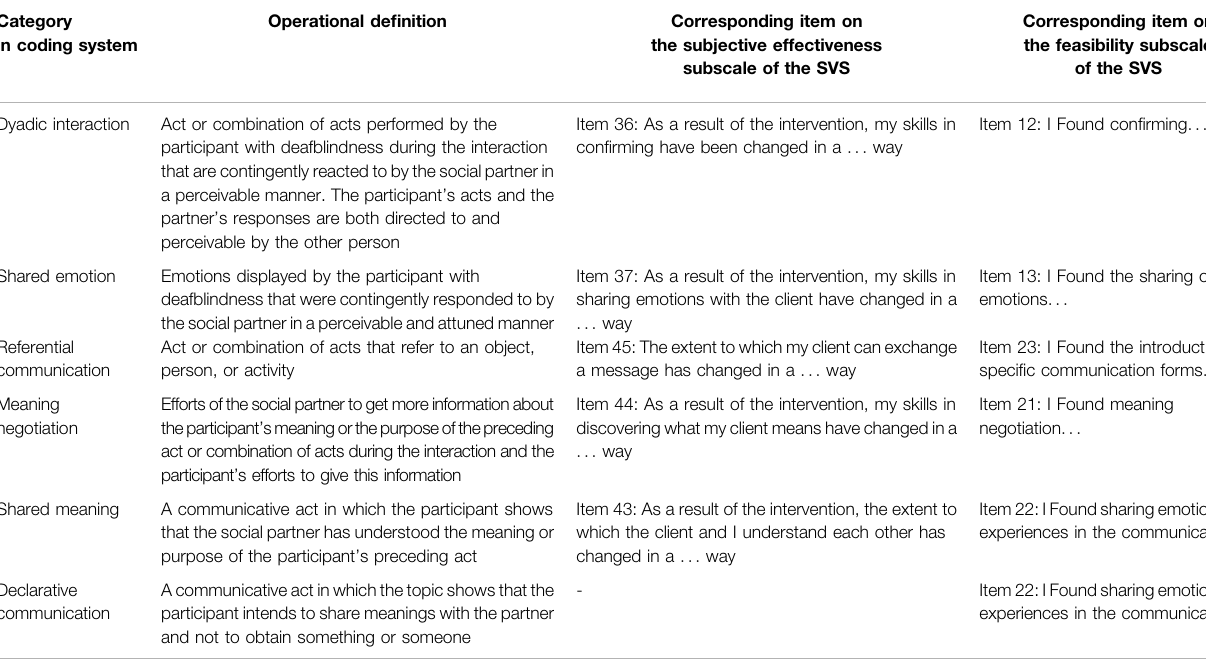
TABLE 2 | Observation categories and corresponding items in two subscales of the Social Validity